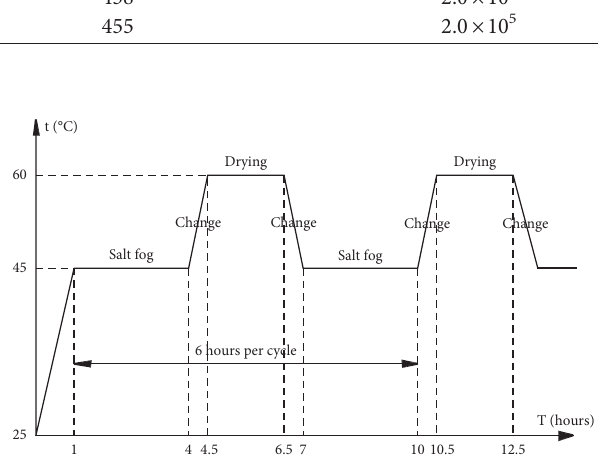
Figure 3: Schematic diagram of dry-wet cycles